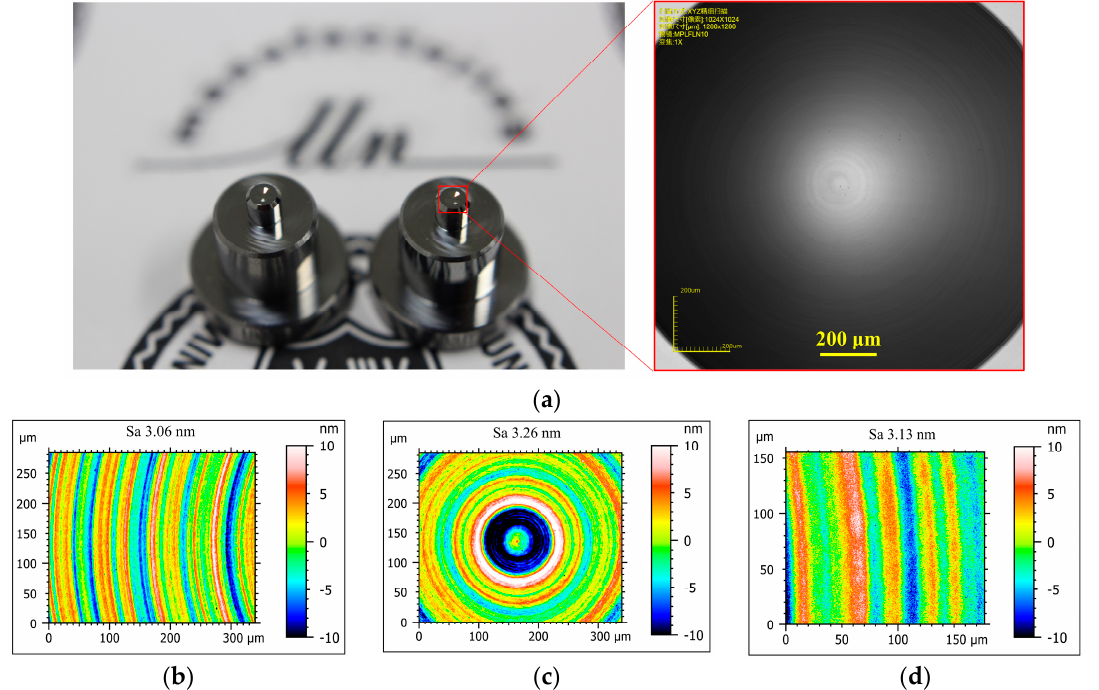
Figure 8. In-LAT machined mold inserts, ( a ) the measured mold surface morphology, ( b ) the fringe area, ( c ) central area, and ( d ) outer platform area.